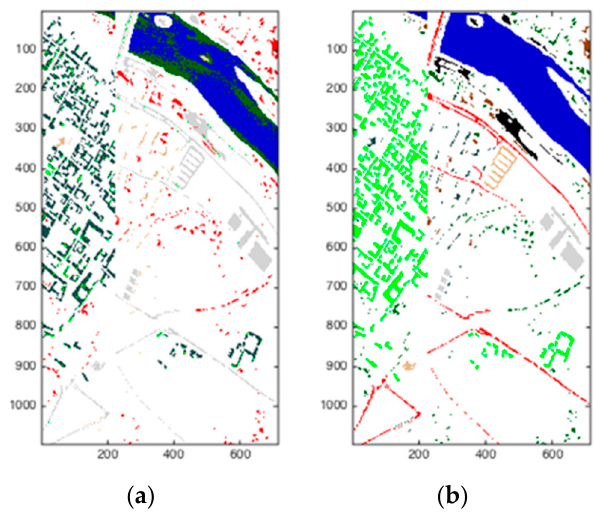
Figure 8. Pavia Image. ( a ) Classification map based on Deep Belief Networks (DBN) and Self-Organizing feature Map (SOM). ( b ) Reference data.